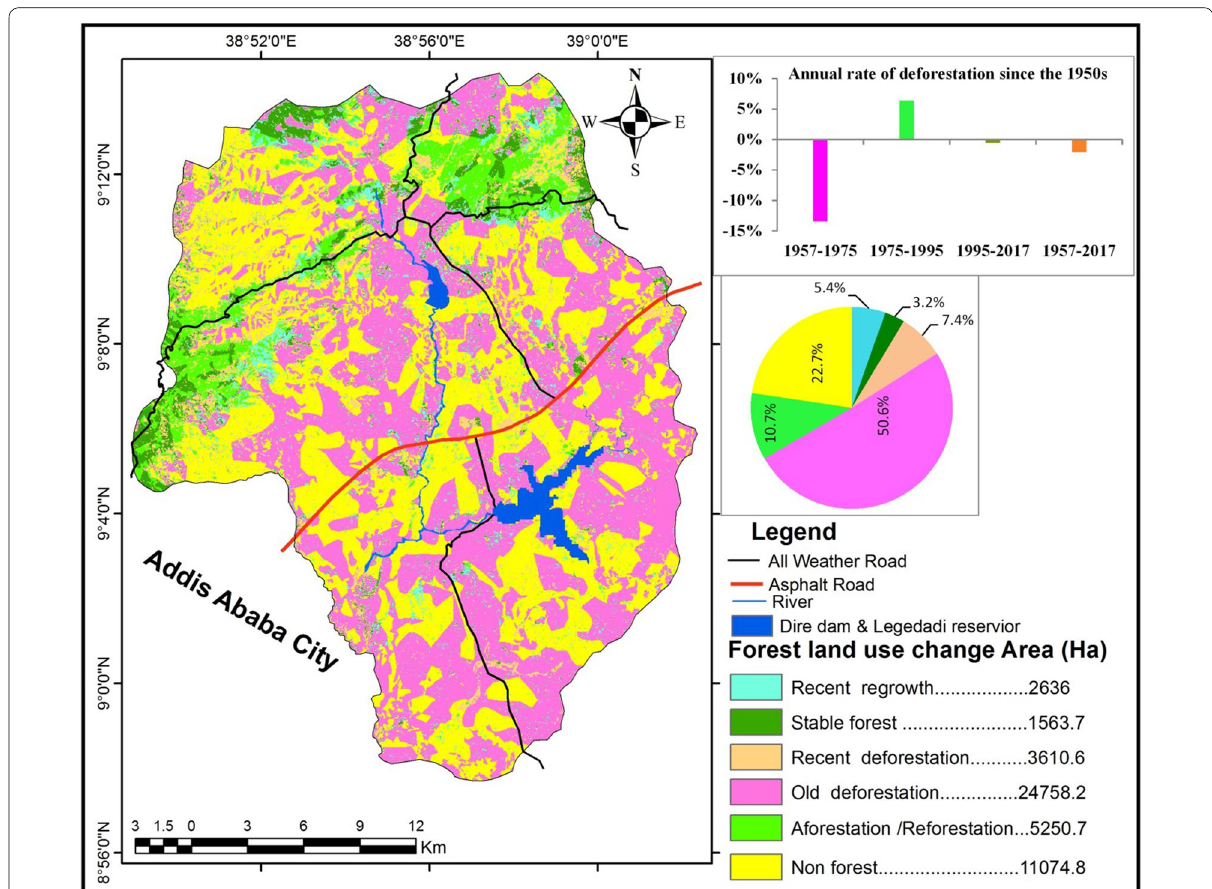
Fig. 7 Forest land use and land cover change trajectory map